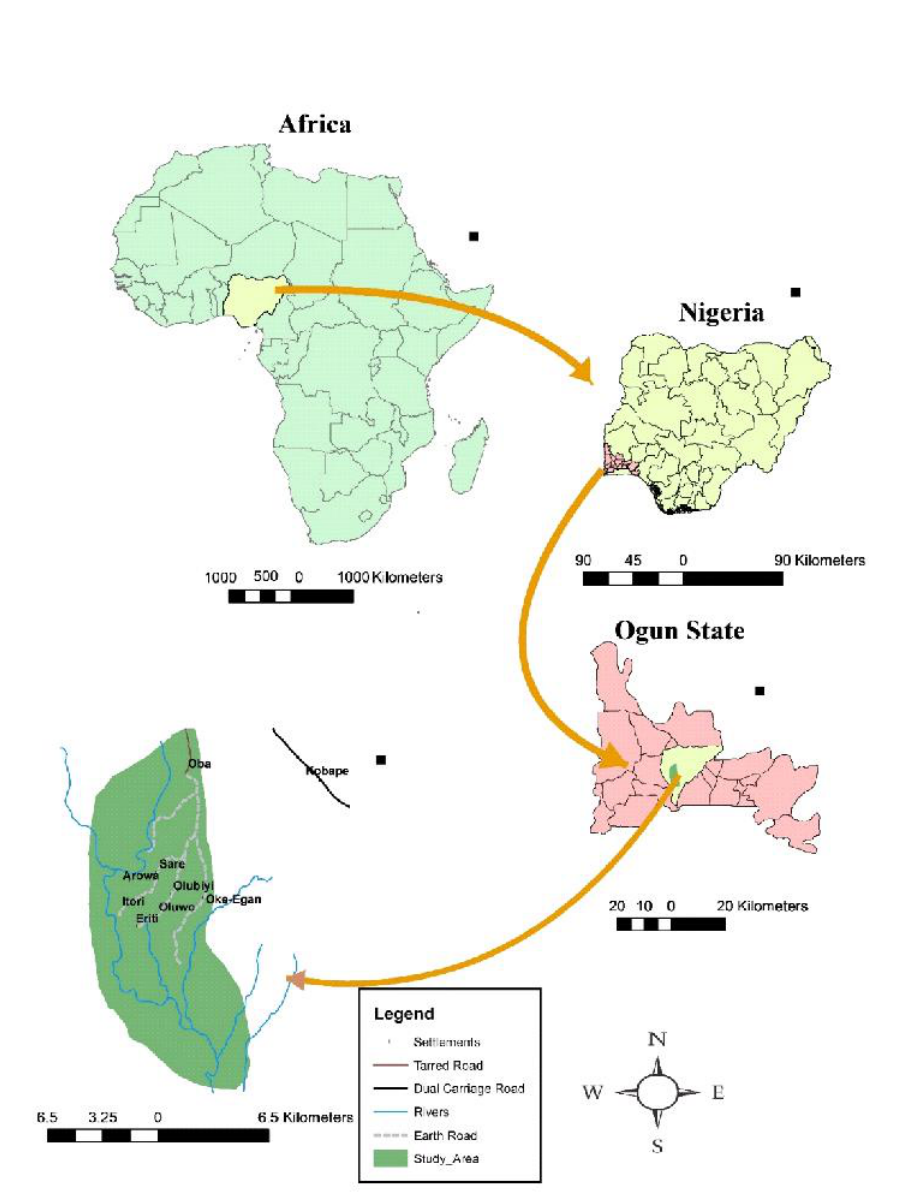
Fig. 1: The Study